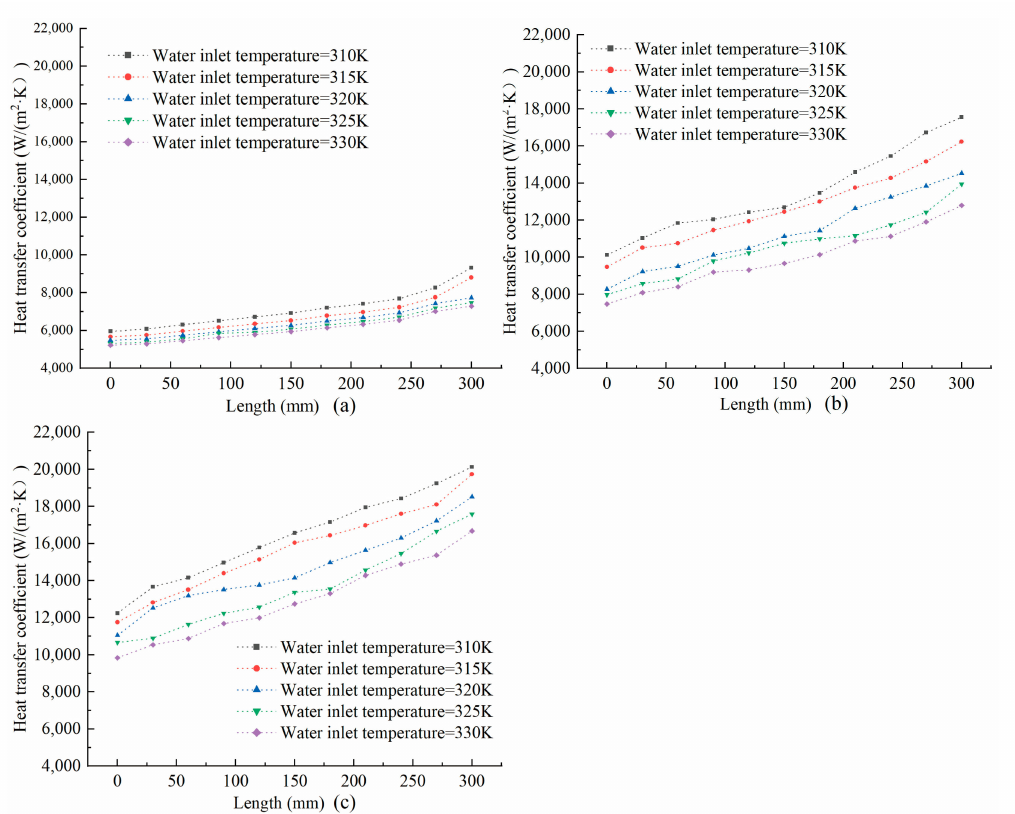
Figure 8. Effect of water inlet temperature on the HTC at a mass flow rate = 0.04 kg/s for the three different tubes. Smooth tube ( a ), corrugated tube with circular corrugations ( b ), and corrugated tube with rectangular corrugations ( c ).